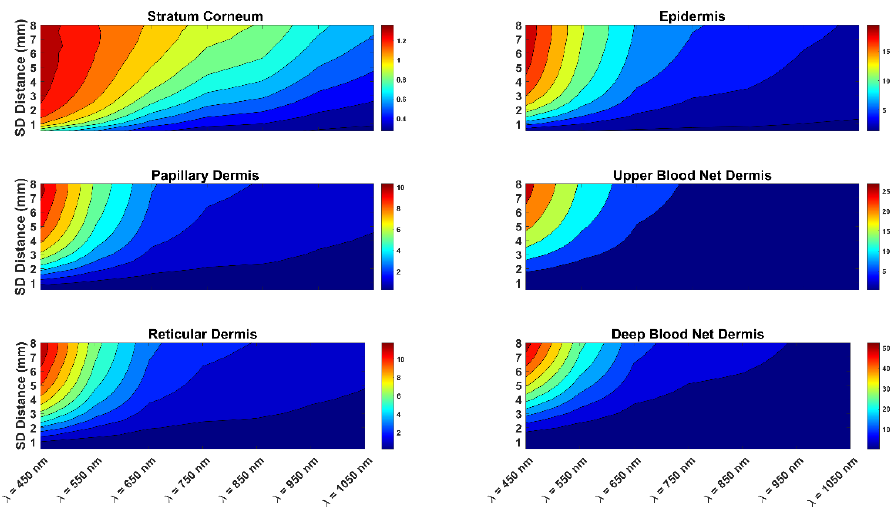
Figure 3. Optical pathlength of the light photons for different skin layers at 20% melanin concentration. The figure shows the effects of different light source wavelengths and source-to-detector separations on the optical pathlength of photons.